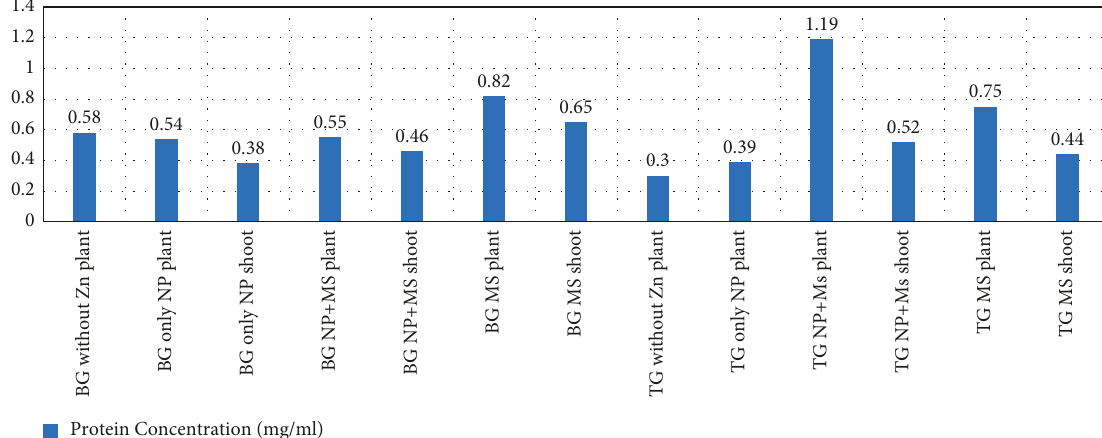
Figure 8: Protein estimation after 14 days, the 1st set. BG: Bengal gram and TG: Turkish gram.